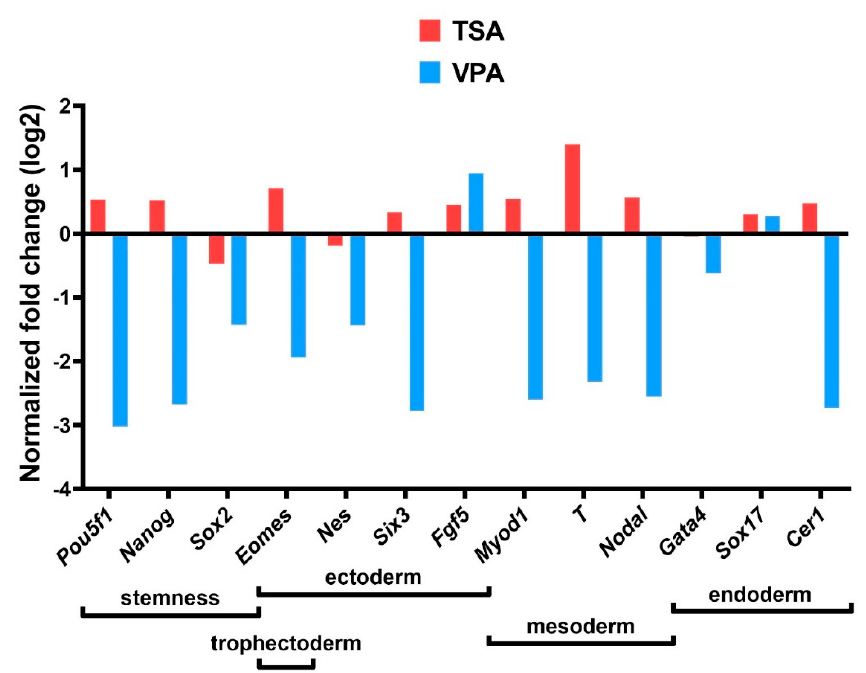
Figure 9. HDACi treatment effect on gene expression. Gene expression on mRNA level analyzed by qPCR, all values normalized to the control group and log-transformed.